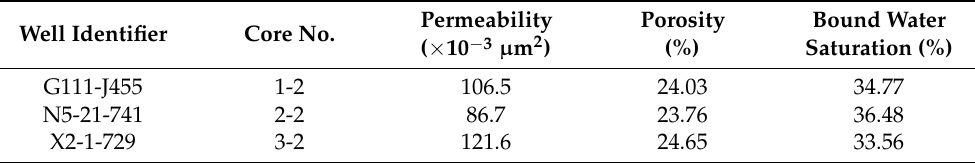
Table 3. Basic data of physical properties of confocal scanning laser natural